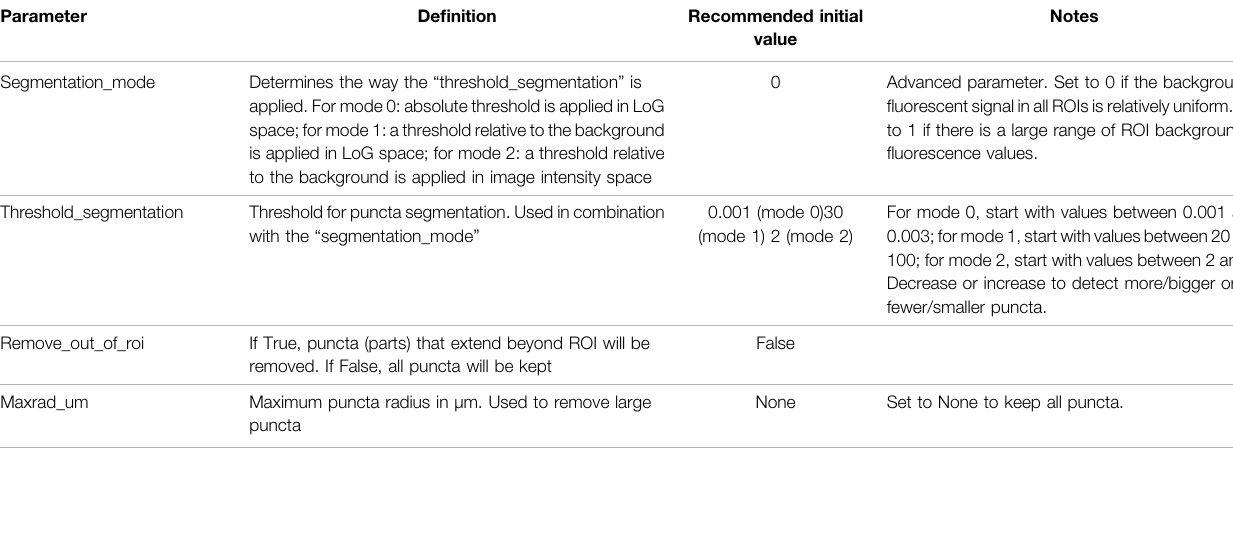
TABLE 2 | ( Continued ) List of parameters for puncta segmentation and analysis (setup_puncta_analysis.ipynb).